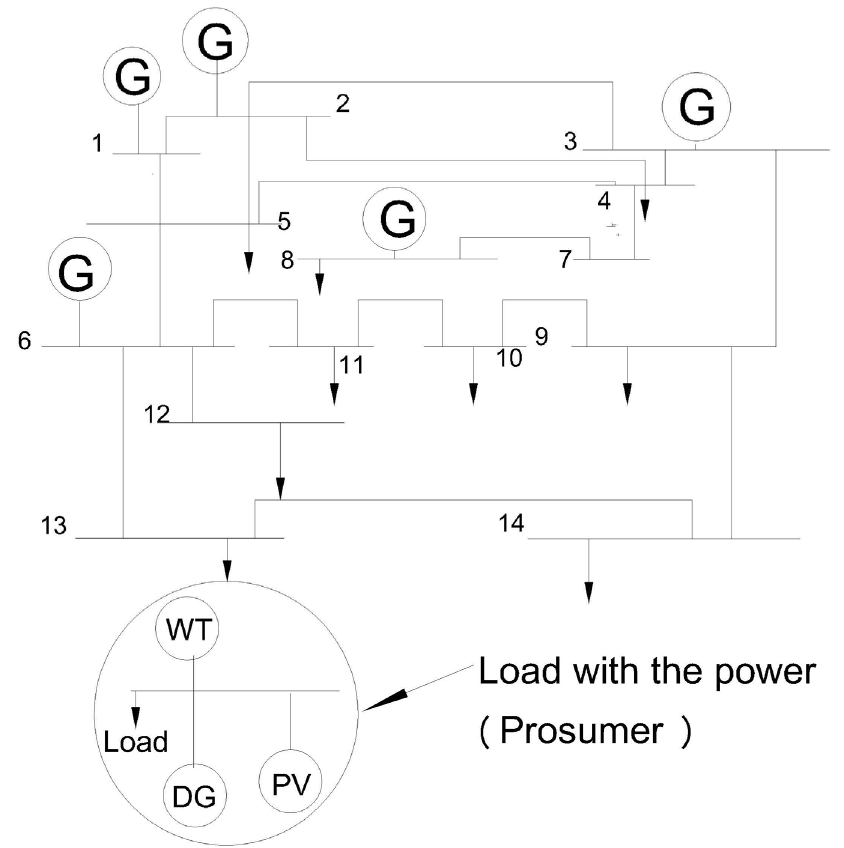
Figure 2. Load with the power in IEEE 14-bus